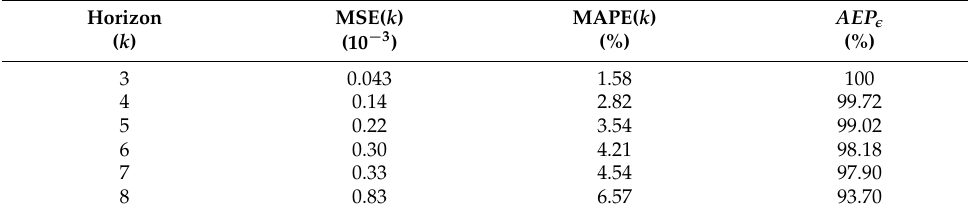
Table 6. Performance of the MODWPT-NAR